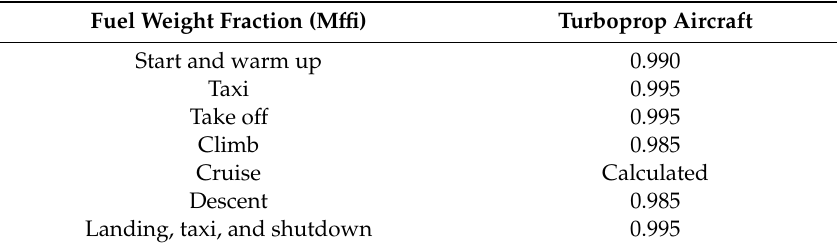
Table 9. Fuel fraction for each segment of a typical flight mission, as suggested by Roskam [40].